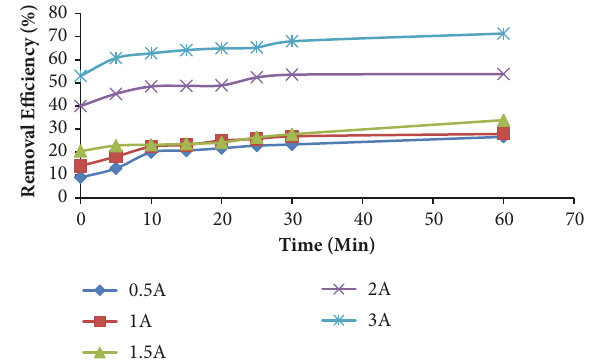
Figure 5: Effect of time and current densities, for PW at 30 ∘ C and pH of 6.